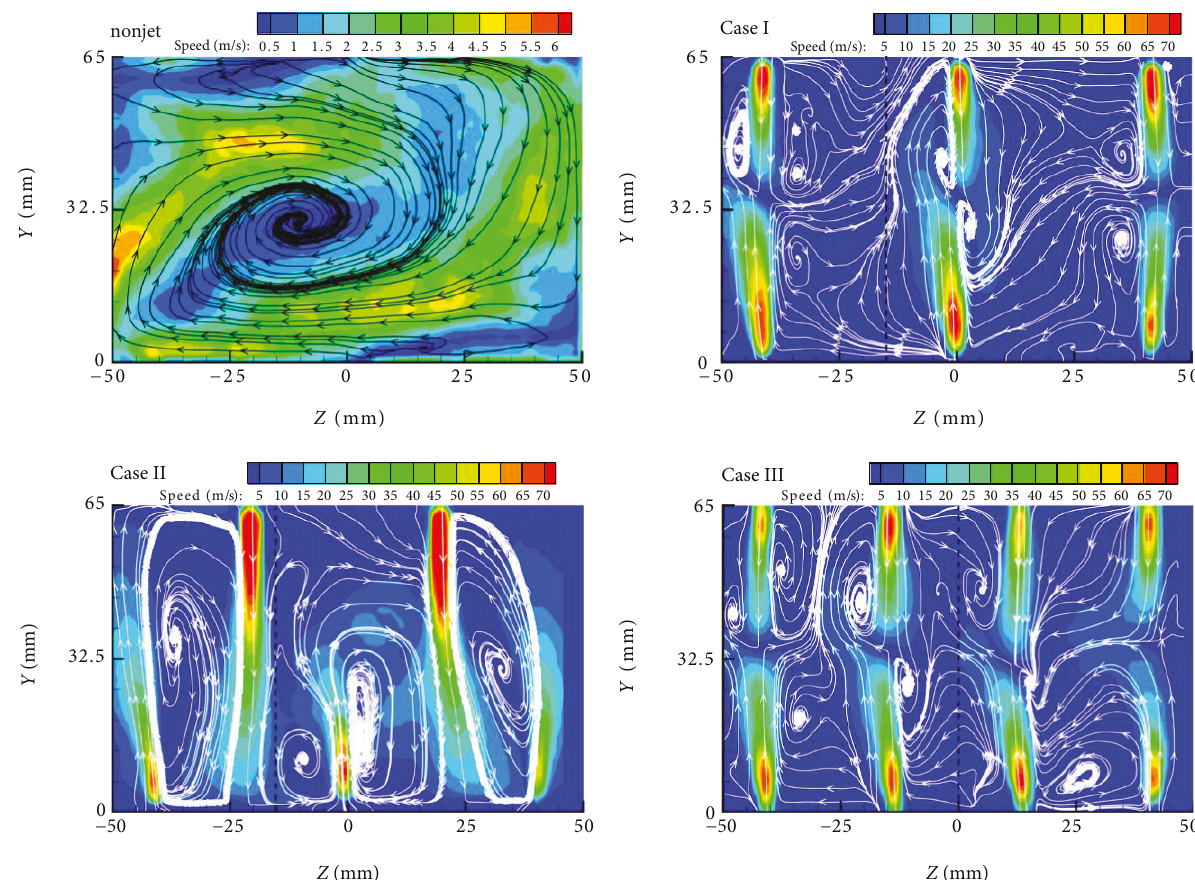
Figure 13: Resulting velocity contours and streamline on the X = 32 5mm